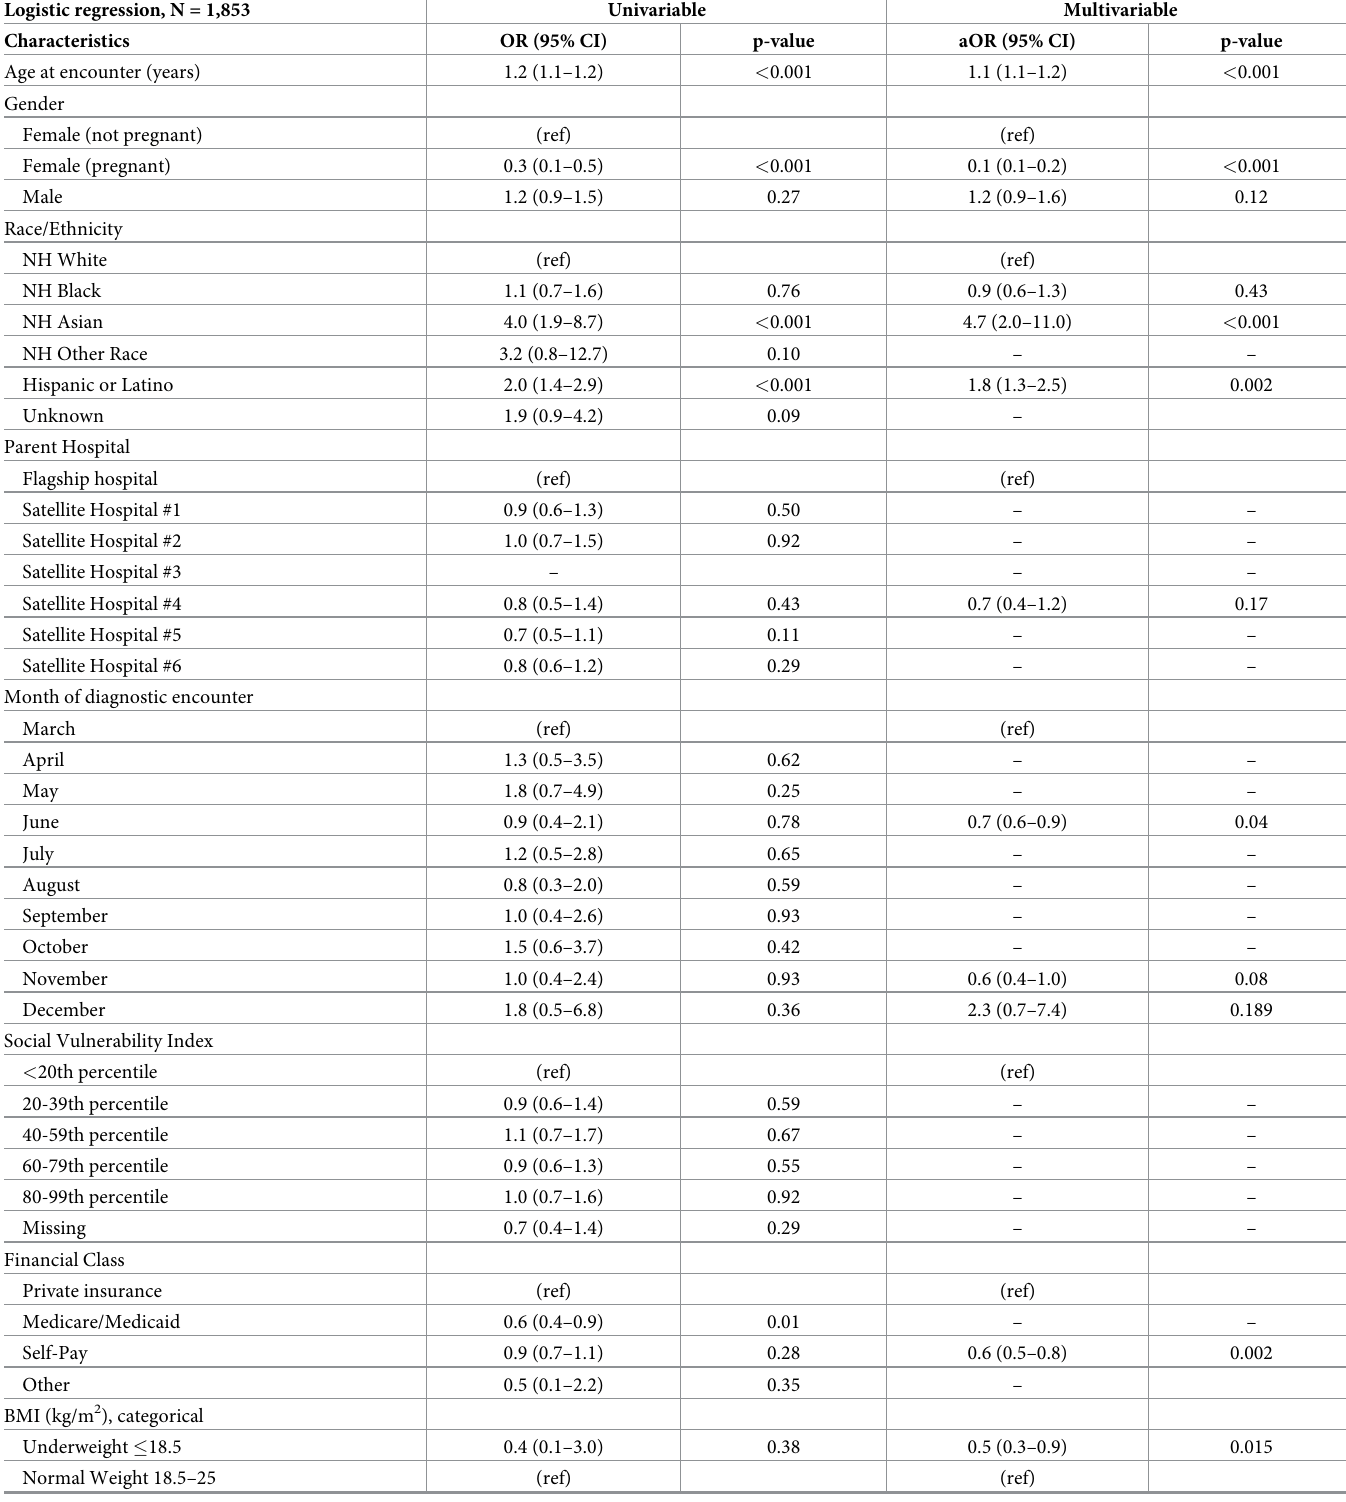
Table 5. Risk factors for pneumonia among COVID-19 patients 18–29 years, diagnosed at a hospital encounter. Logistic regression, N =